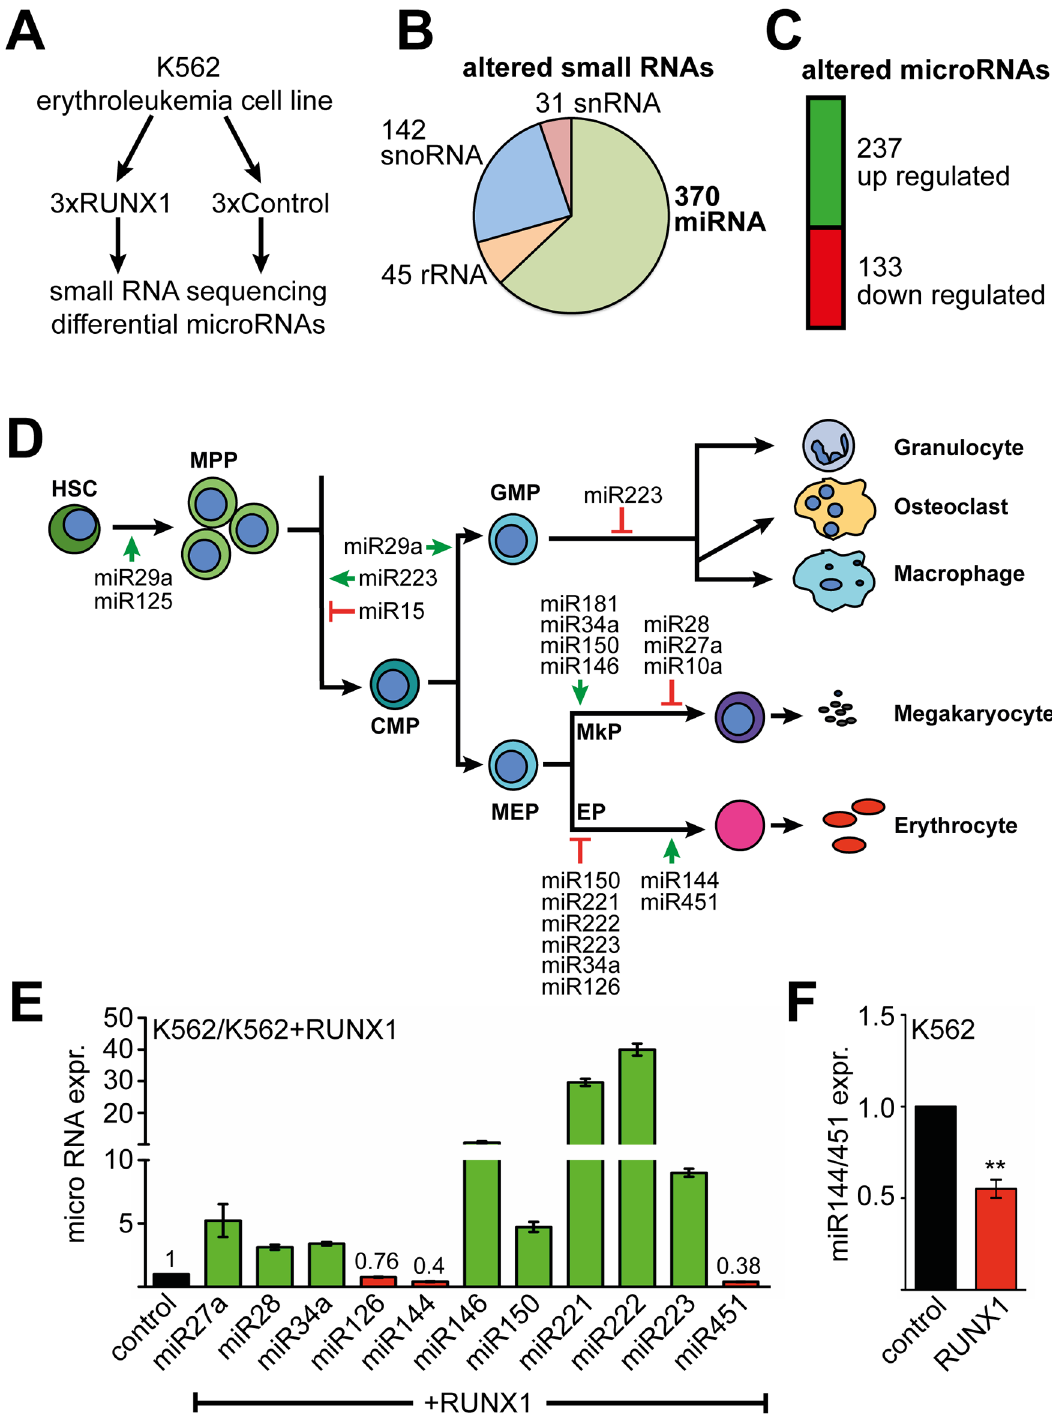
Fig 1. Identification of RUNX1 regulated microRNAs. (A) Schematic representation of the experimental setup. K562 cells were transduced with RUNX1 expression vector or empty vector control. The transductions were performed in independent triplicates and differentially expressed microRNAs were determined by small-RNA sequencing. (B) 588 small RNAs were differentially expressed upon RUNX1 expression in K562 cells. 31 were snRNAs (small nuclear RNA), 45 rRNAs (ribosomal RNA), 142 snoRNAs (small nucleolar RNA) and 370 microRNAs. RNAs were included if they displayed an at least -0.5 or +0.5 log2-fold change and a P-value < 0.05. (C) Of the 370 identified microRNAs, 237 were up-regulated and 133 down-regulated upon RUNX1 expression. (D) Schematic representation of hematopoiesis from the stem cell throughout the myeloid lineage. Those microRNAs are shown, which